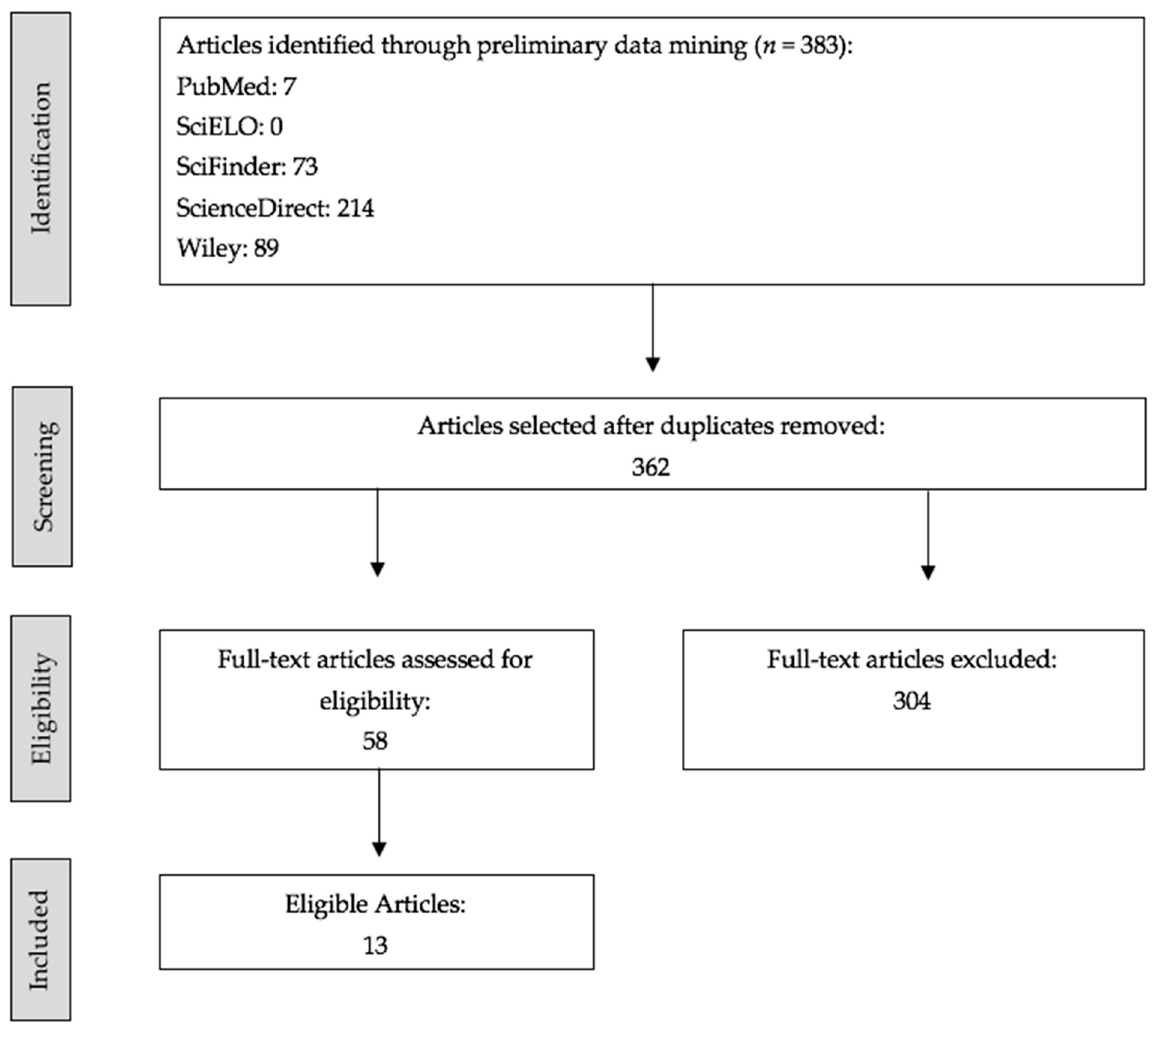
Figure 2. Flowchart showing the methodology and selection process used in the present review.